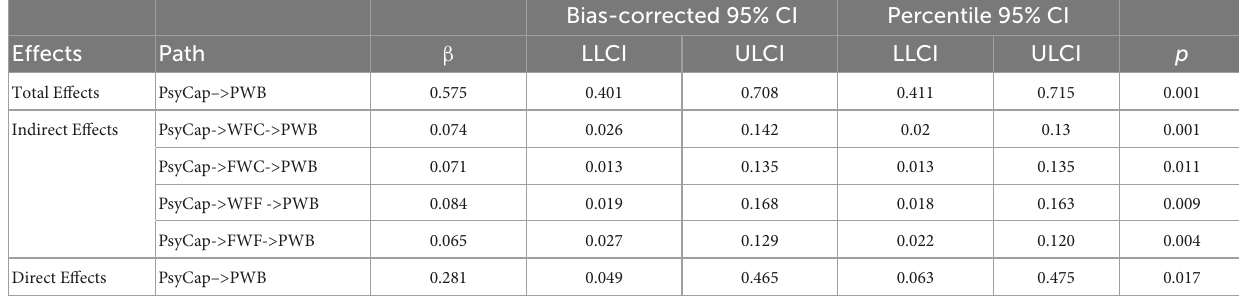
TABLE 4 Results for mediating effects.